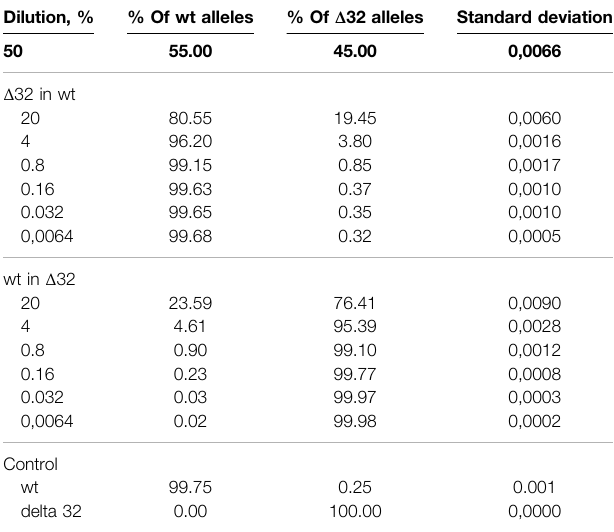
TABLE 2 | Detection of the ratios of CCR5 Δ 32 mutant and wild-type alleles by ddPCR using genomic DNA dilution. Dilution, % % Of wt alleles % Of Δ 32 alleles Standard